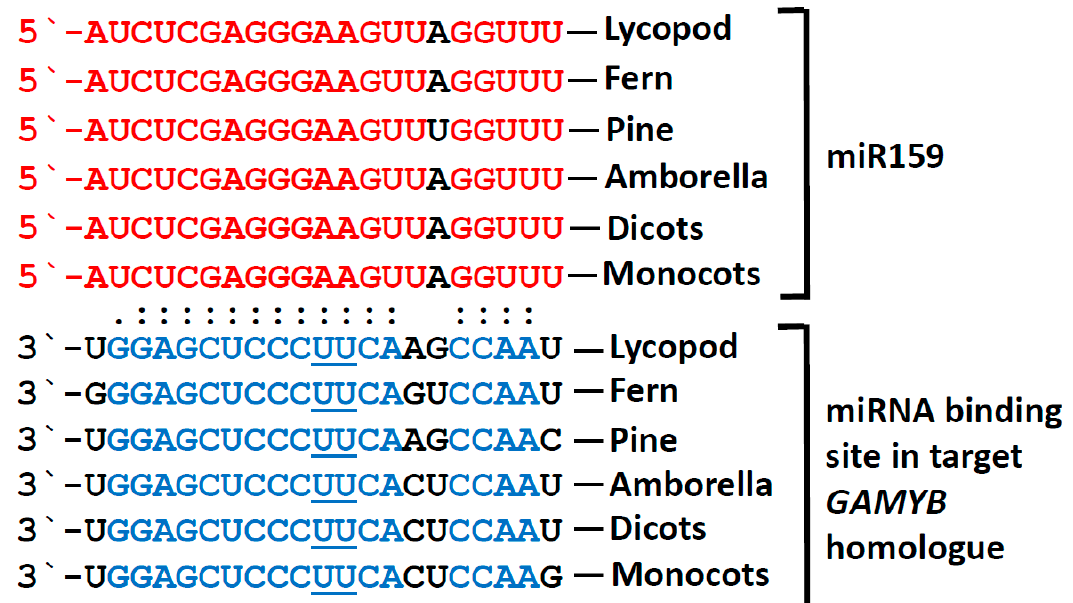
Figure 1. The microR159 (miR159)- GAMYB regulatory pathway appears highly conserved in land plants. Similar/identical miR159 isomiRs (shown in red) are found in most plant linages, including Lycopods ( Selaginella uncinata ; [3]) ferns ( Salvinia cucullata ; [3]), pine ( Pinus densata ; [36]), Amborella [37], dicots, and monocots (miRbase; [11]). Highly similar and complementary miR159 binding sites (shown in blue) are found in GAMYB homologues from lycopods ( Selaginella moellendorffii ; [20]), ferns ( Salvinia cucullata ; [11]), pine ( Larix kaempferi ; [38]), Amborella and many different monocots and dicots. Variant nucleotide positions are shown in black. However, throughout the plant kingdom, variation is not limited to these positions; for example, see [39].